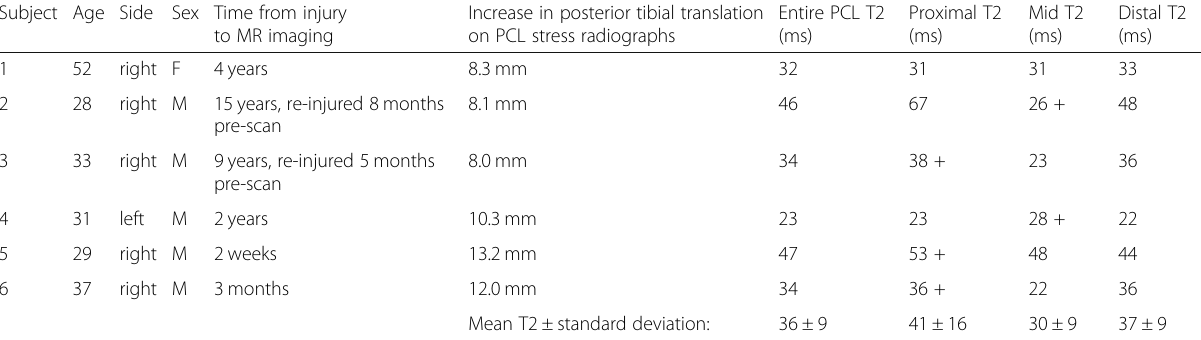
Table 1 Subject demographics, clinical MR imaging information and T2 mapping values for patients with PCL insufficiency showing a continuous ligament on MR images Subject Age Side Sex Time from injury to MR